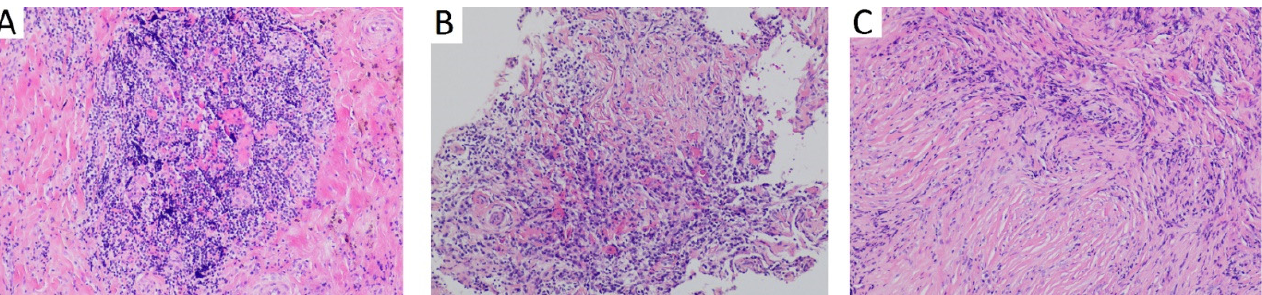
Figure 3. Biopsy of left mastoid—case 1. Hematoxylin and eosin (H&E). Original magnification: A–D 100×, E 200×. Fibrous tissue with ( A ) foci of dense lymphoplasmacytic infiltration. ( B , C ) Storiform fibrosis is present, as well as areas suggestive of obliterative phlebitis.